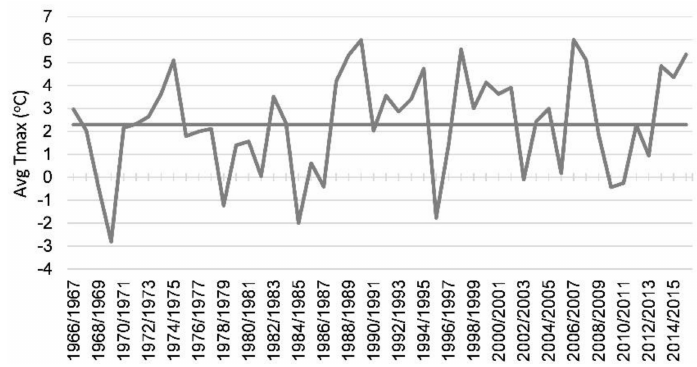
Figure 2. Course of the average Tmax in the winter season with long-term average value in Pozna´n-Ławica in the years